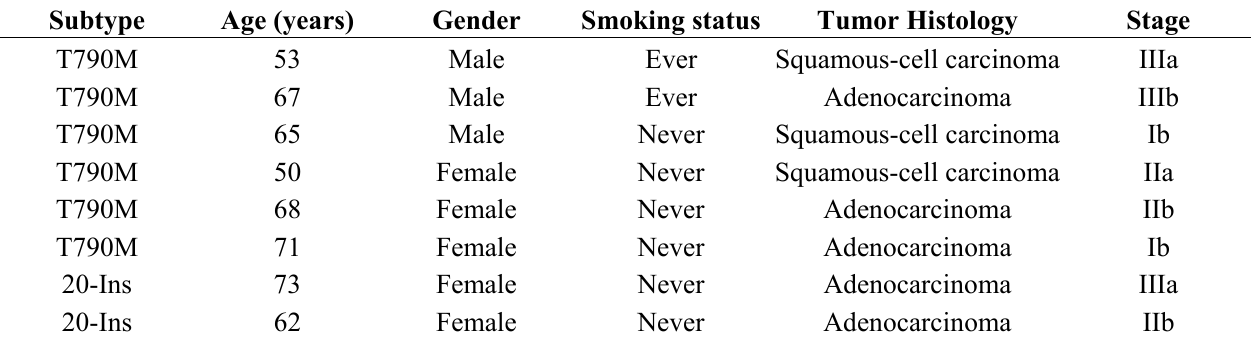
Table 5. Listing of features of patients whose tumors harbored EGFR TKI resistant